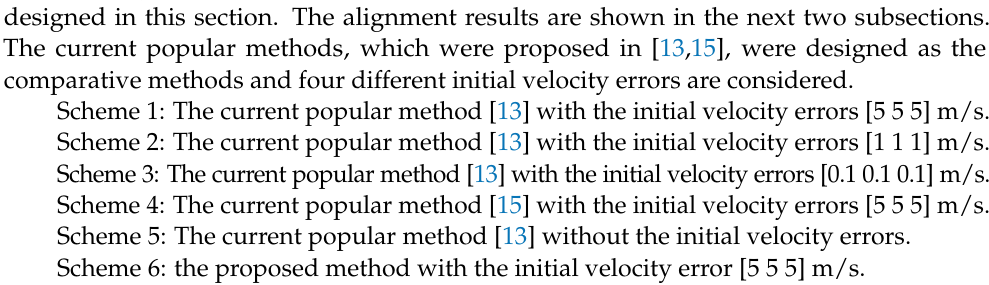
Sensors 2023 , 23 , x FOR PEER REVIEW